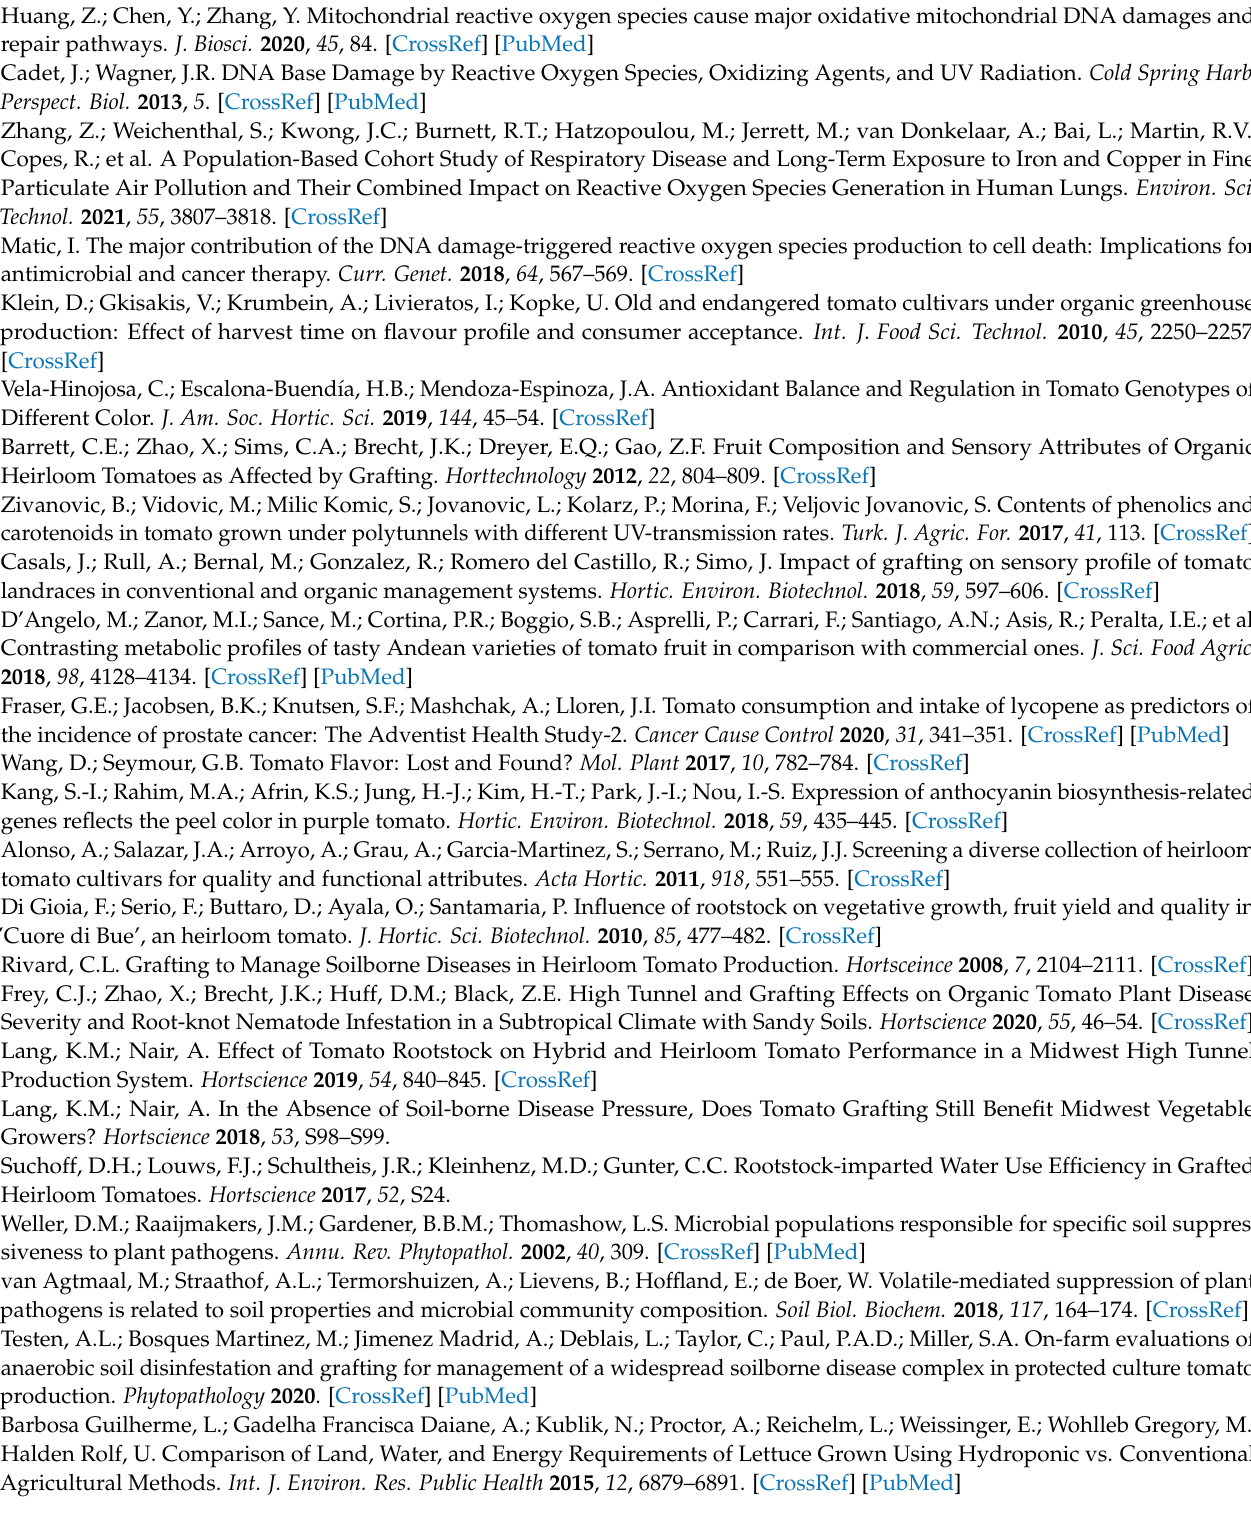
Figueroa-Mendez, R.; Rivas-Arancibia, S. Vitamin C in Health and Disease: Its Role in the Metabolism of Cells and Redox State